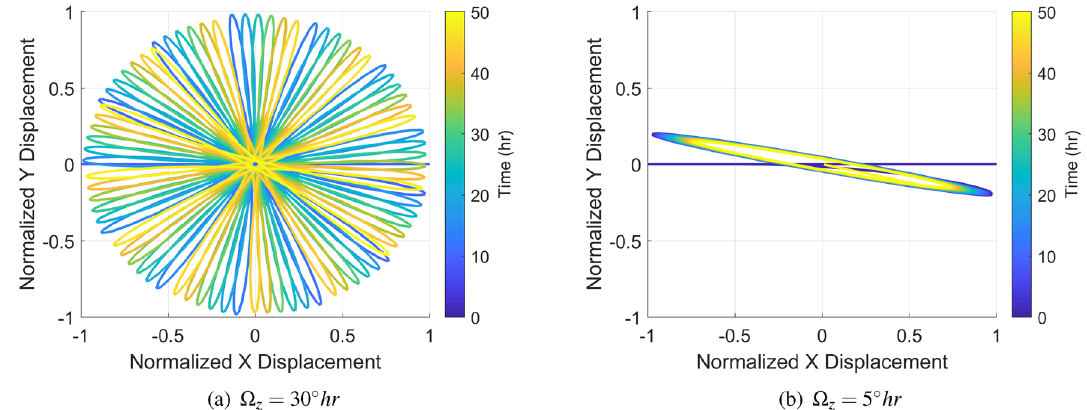
Figure 7. Dead area simulation results with input rates larger and smaller than the threshold.